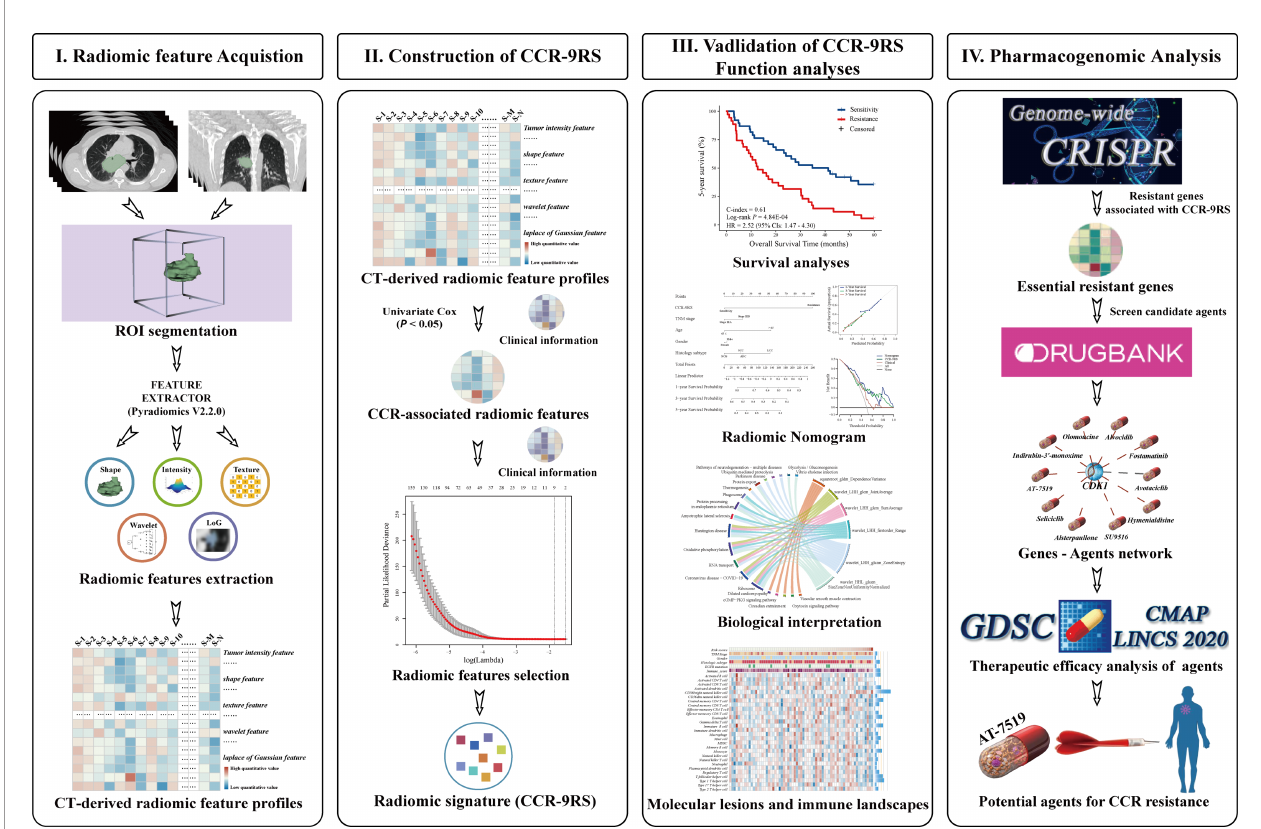
FIGURE 1 | Flowchart of developing and validating of a radiomic signature derived from computer tomography (CT) for the patients with NSCLC receiving CCR